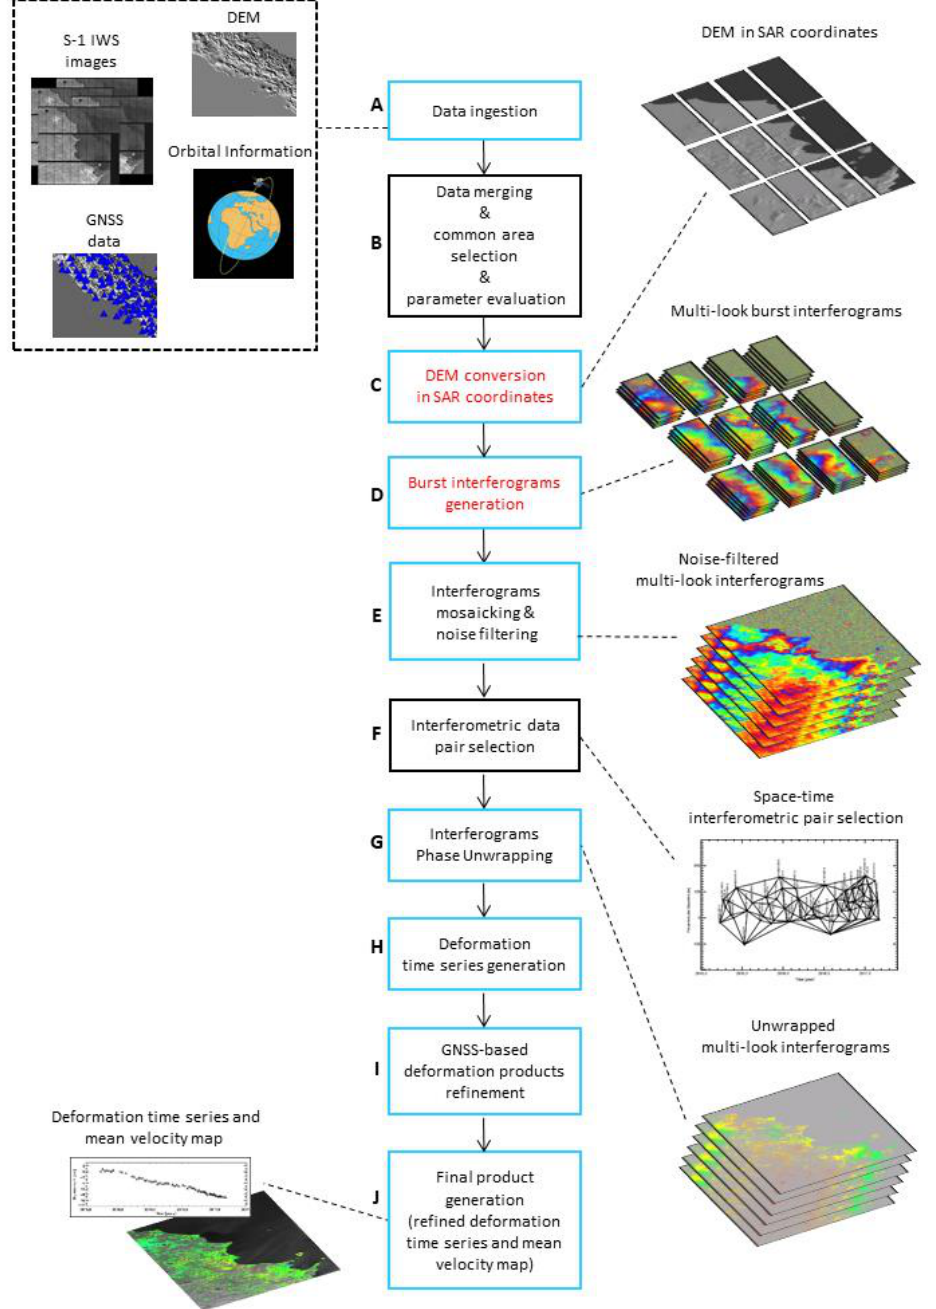
Figure 1. Block diagram of the S-1 IWS P-SBAS processing chain workflow modified from [20].